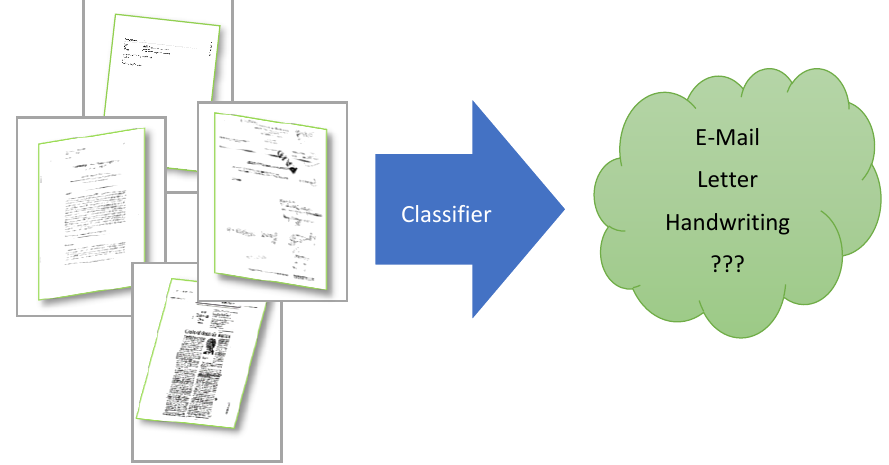
Figure 1. Document classification-related general processing pipe. The input of the classifier is a document image, and the classifier output is the estimated type/label of the input document.